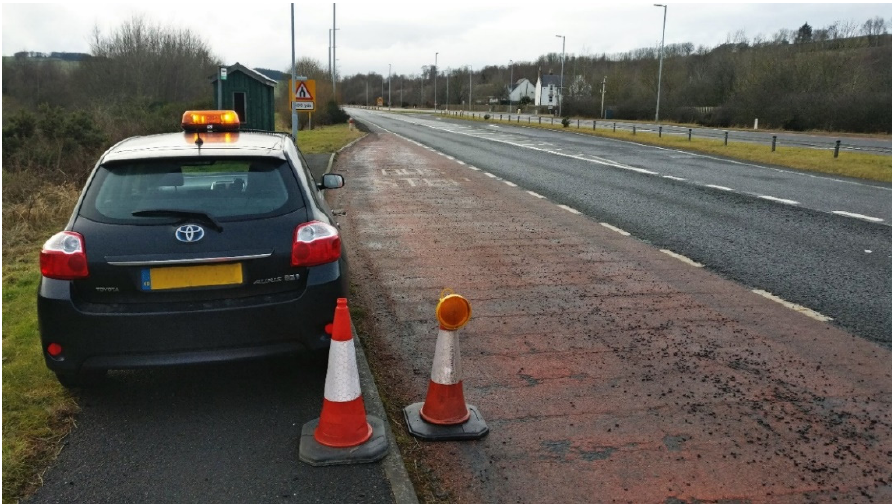
Figure 2. Typical radar speed survey arrangement.